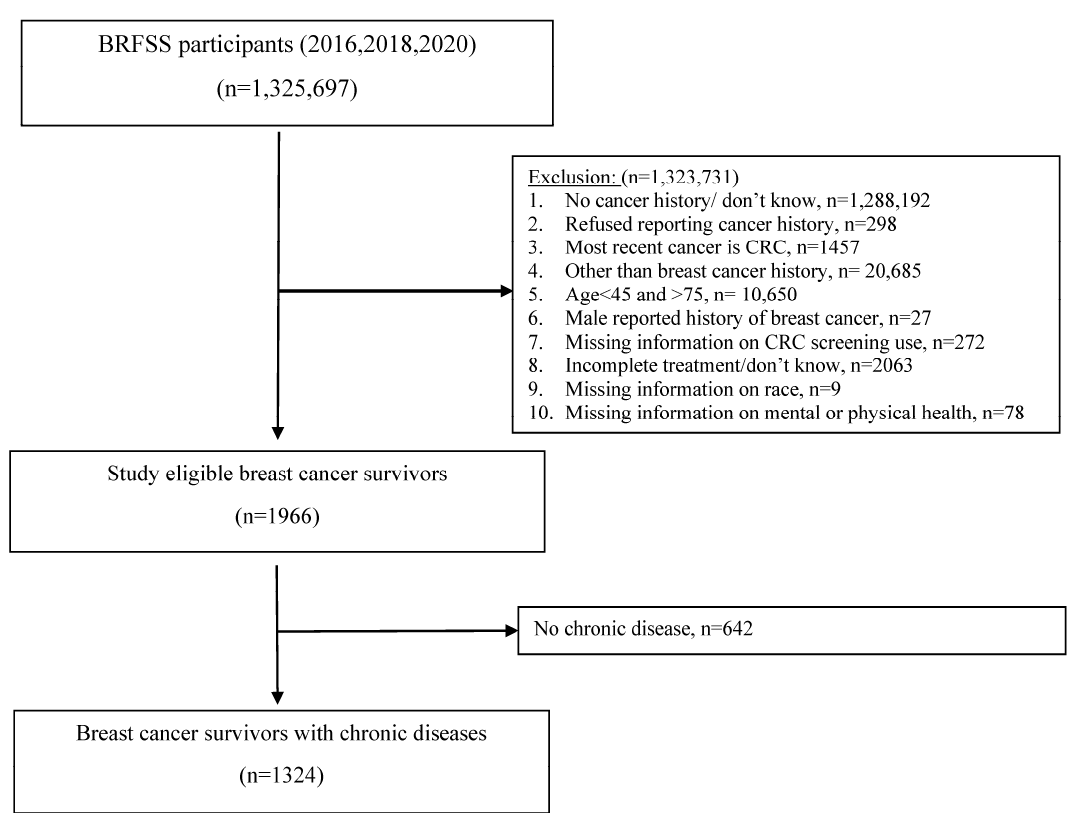
Figure A1. Selection process of eligible participants. Abbreviation: BRFSS, Behavioral Risk Factor Surveillance System; CRC, colorectal cancer. Table A1. Missing values for each factor among breast cancer survivors a. Chronic Diseases (n = 702)